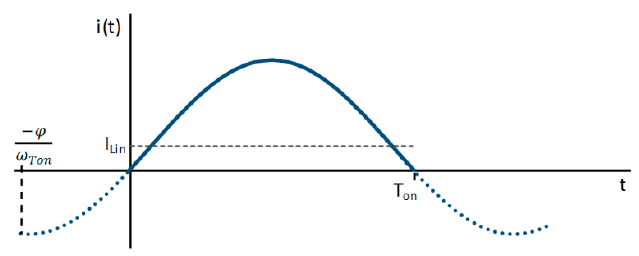
Figure 6. Primary current of the transformer i(t) during T on time interval.